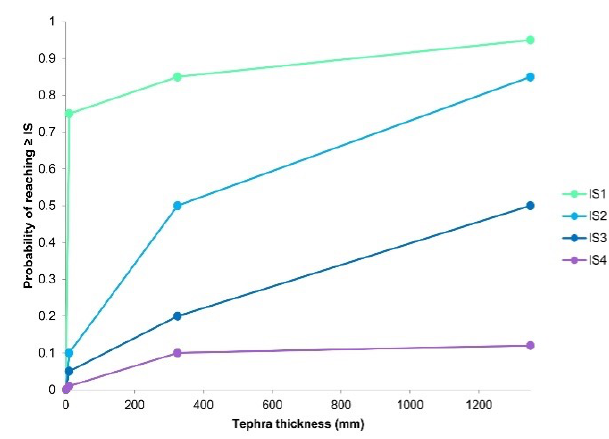
Figure 8: Forestry fragility